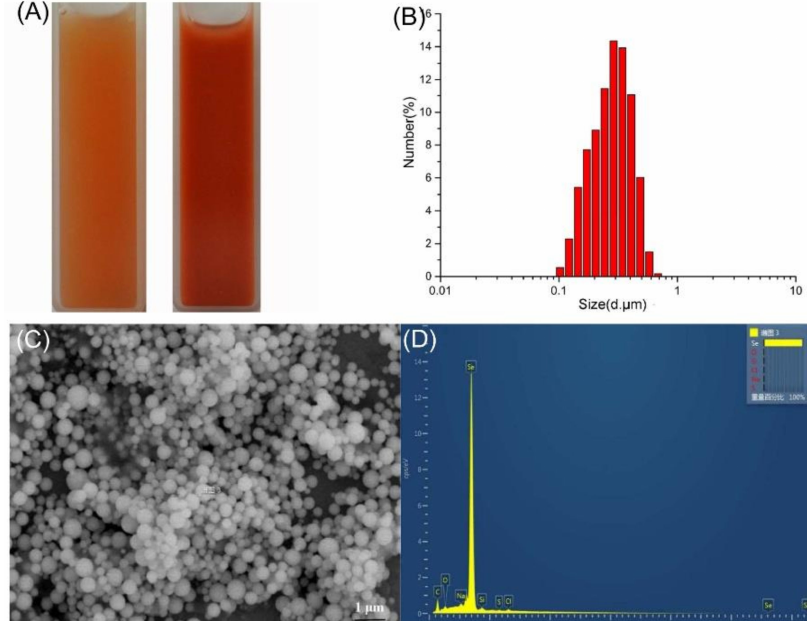
Figure 6. DLS spectra of purified SeNPs produced by A. faecalis Se03 in YEP supplemented with 5.0 mM selenite. ( A ) Selenite-dosing cells (left) and purified nano-selenium (right); ( B ) size distribution of purified SeNPs; ( C ) SEM micrographs of purified SeNPs. ( D ) EDX analysis of purified SeNPs